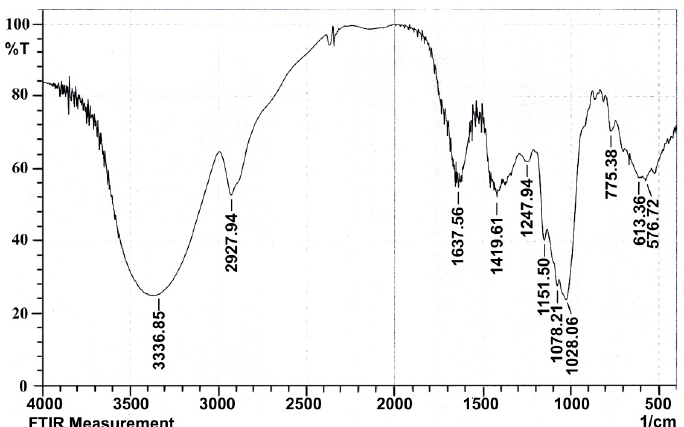
Figure 4. Infrared spectral analysis of LBP.